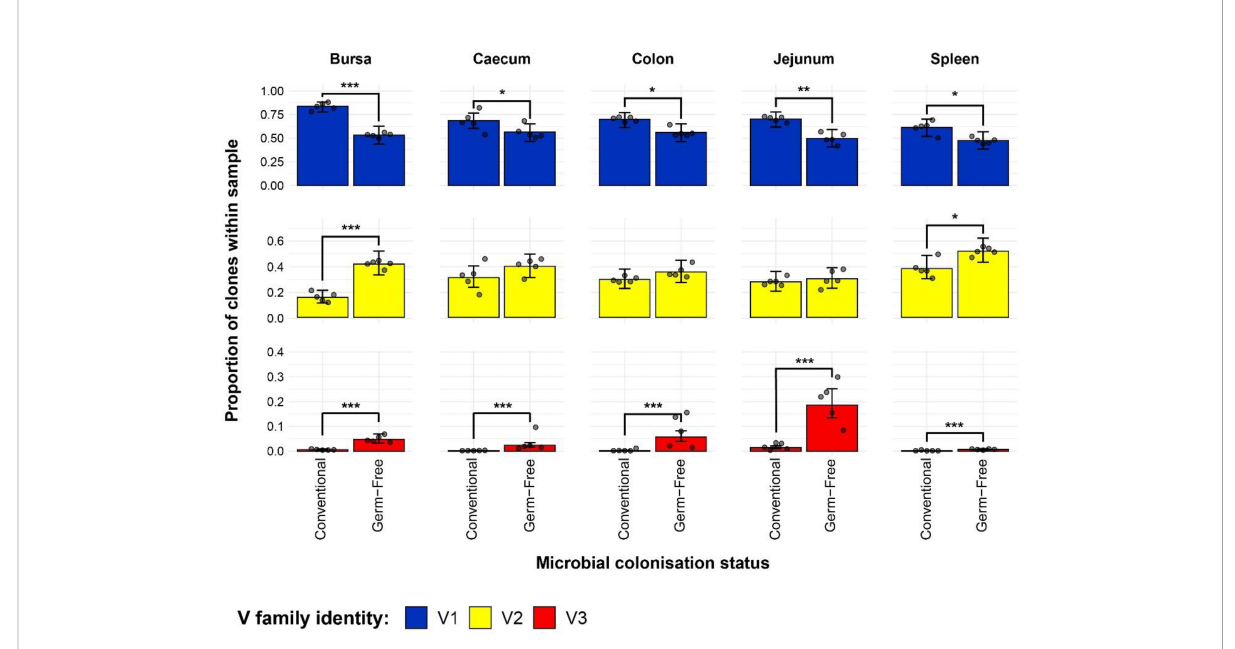
FIGURE 7 TCR b V family usage in individual tissue samples across treatment groups. V family identities are shown in blue (V b 1), yellow (V b 2), and red (V b 3). Grey dots represent individual bird observations for each V family. Error bars represent 95% bootstrap con fi dence intervals for the point estimates generated from 1000 simulations of the model. Statistically signi fi cant differences between the model estimates are depicted above the plots based on their corresponding p-values: *p < 0.05; **p < 0.01, ***p <